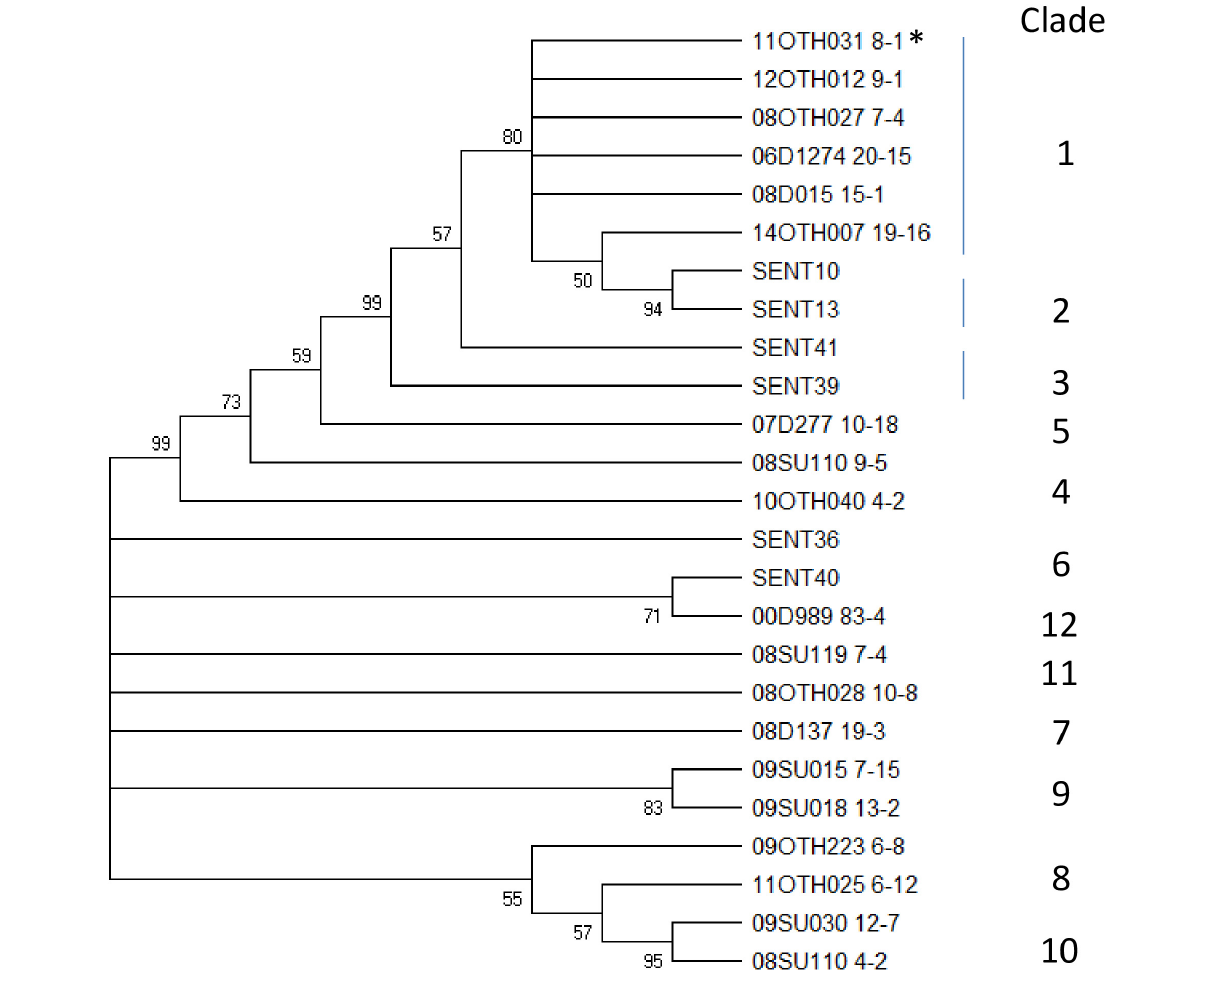
FIGURE 5 | A Neighbor Joining tree illustrating the SNP typing results. This bootstrap consensus tree was generated using an alignment of 60 SNP reads for 25 S . Enteritidis isolates representative of 12 distinct clades including the six unusual isolates described in this report. Values at nodes indicate bootstrap values > 50% and the clade designation is indicated to the right of the tree. *Indicates the isolate originally identified as clade